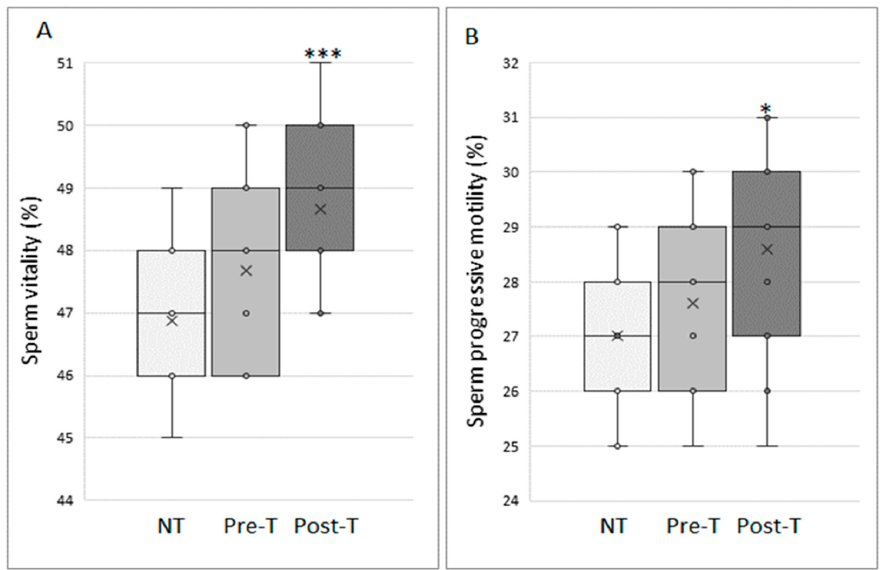
Figure 1 . Sperm vitality ( A ) and sperm progressive motility ( B ) of cryopreserved sperm that are untreated (NT; n = 25), treated with 20 mg/mL myo-inositol for 20 min before (Pre-T; n = 25), or after (Post-T; n = 25) sperm cryopreservation. Graphical diagrams are plotted as box–whisker plots, where boxes show the interquartile range with median and mean values, and whiskers represent min and max confidence intervals. * p < 0.05; *** p < 0.001.